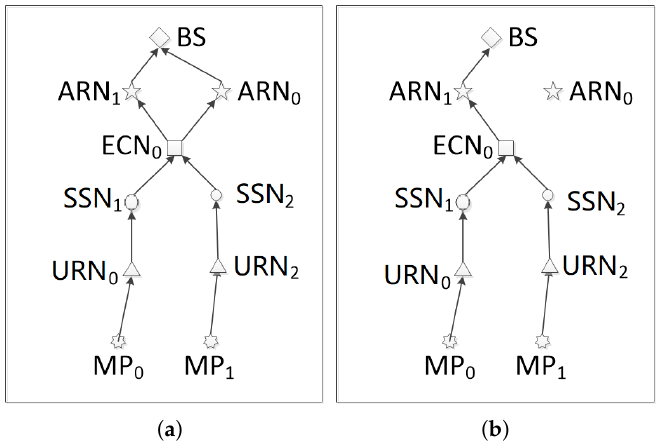
Figure 2. The topology of the network with 2 MPs; ( a ) Before removing; ( b ) After removing. The pseudo code of the proposed AC-ETO is elaborated in Algorithm